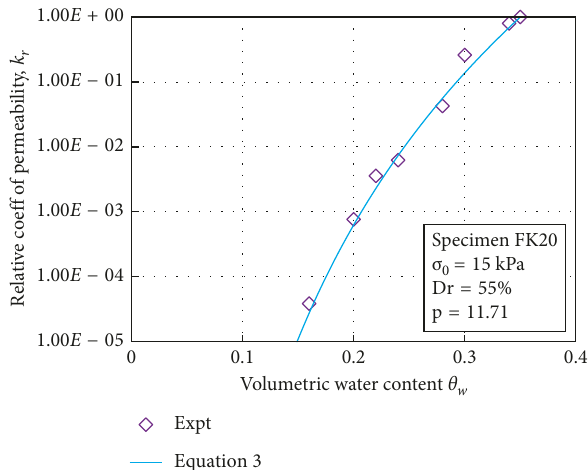
Figure 15: Permeability changes against volumetric water content for FK40 soils.